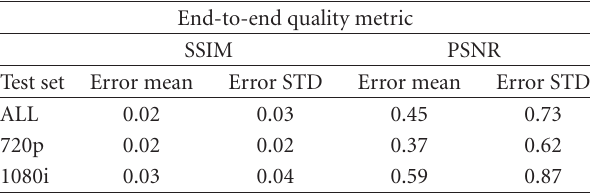
Table 9: Mean errors and standard deviations of model for Qm e-e